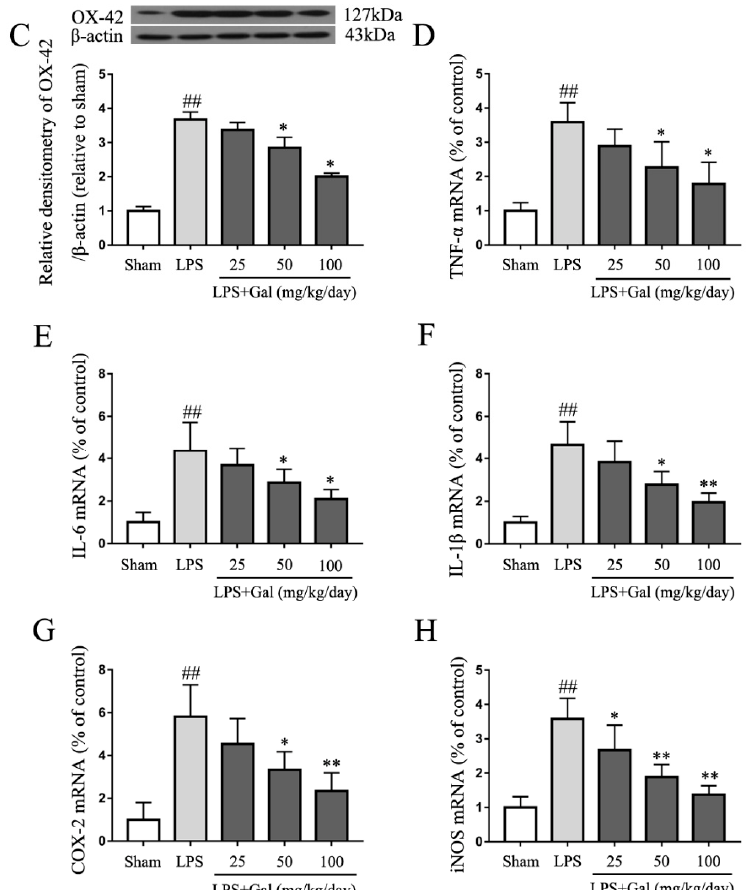
Figure 1. Galangin inhibited the activation of microglial cells in an LPS-induced Parkinson’s disease (PD) rat model. All rats were randomly divided into five groups and each of the groups contained 12 rats: the sham-operated group; LPS treatment group, the right substantia nigra pars compacta